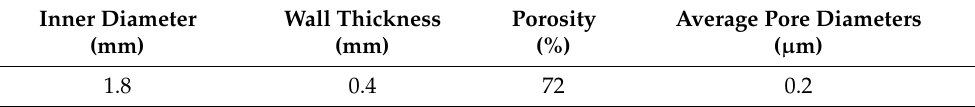
Table 1. Characteristics of the PP membranes used in the experiments (manufacturer’s